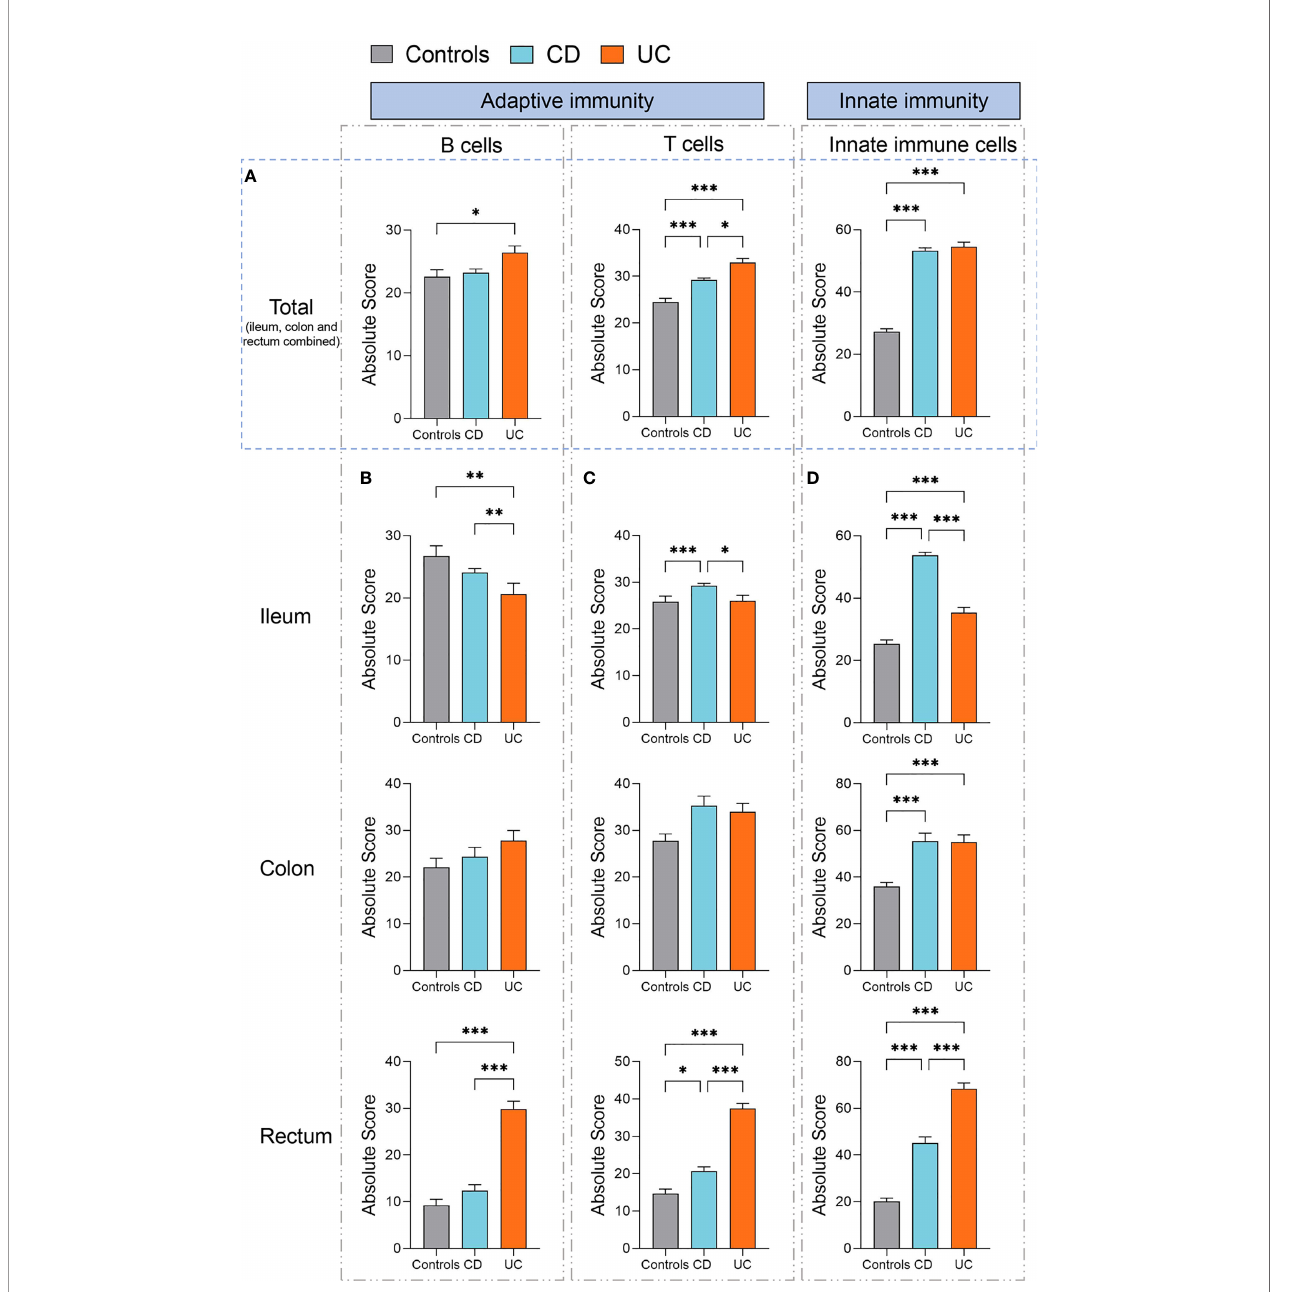
FIGURE 3 | Absolute quantity of immune cells pro fi ling in patients with IBD and healthy individuals. (A) Comparisons of the total B cells, T cells, and innate immune cells (ileum, colon, and rectum combined) among three disease subtypes (healthy controls, n=461; CD, n=1663; UC, n=652). (B) Comparisons of the total B cells among three disease subtypes in the ileum, colon, and rectum respectively. (C) Comparisons of the total T cells among three disease subtypes in the ileum, colon, and rectum respectively. (D) Comparisons of the total innate immune cells among three disease subtypes in the ileum, colon, and rectum, respectively. Statistical signi fi cance was determined by Kruskal – Wallis non-parametric test and Dunn ’ s multiple comparisons test. * p < 0.05, ** p < 0.01, *** p <